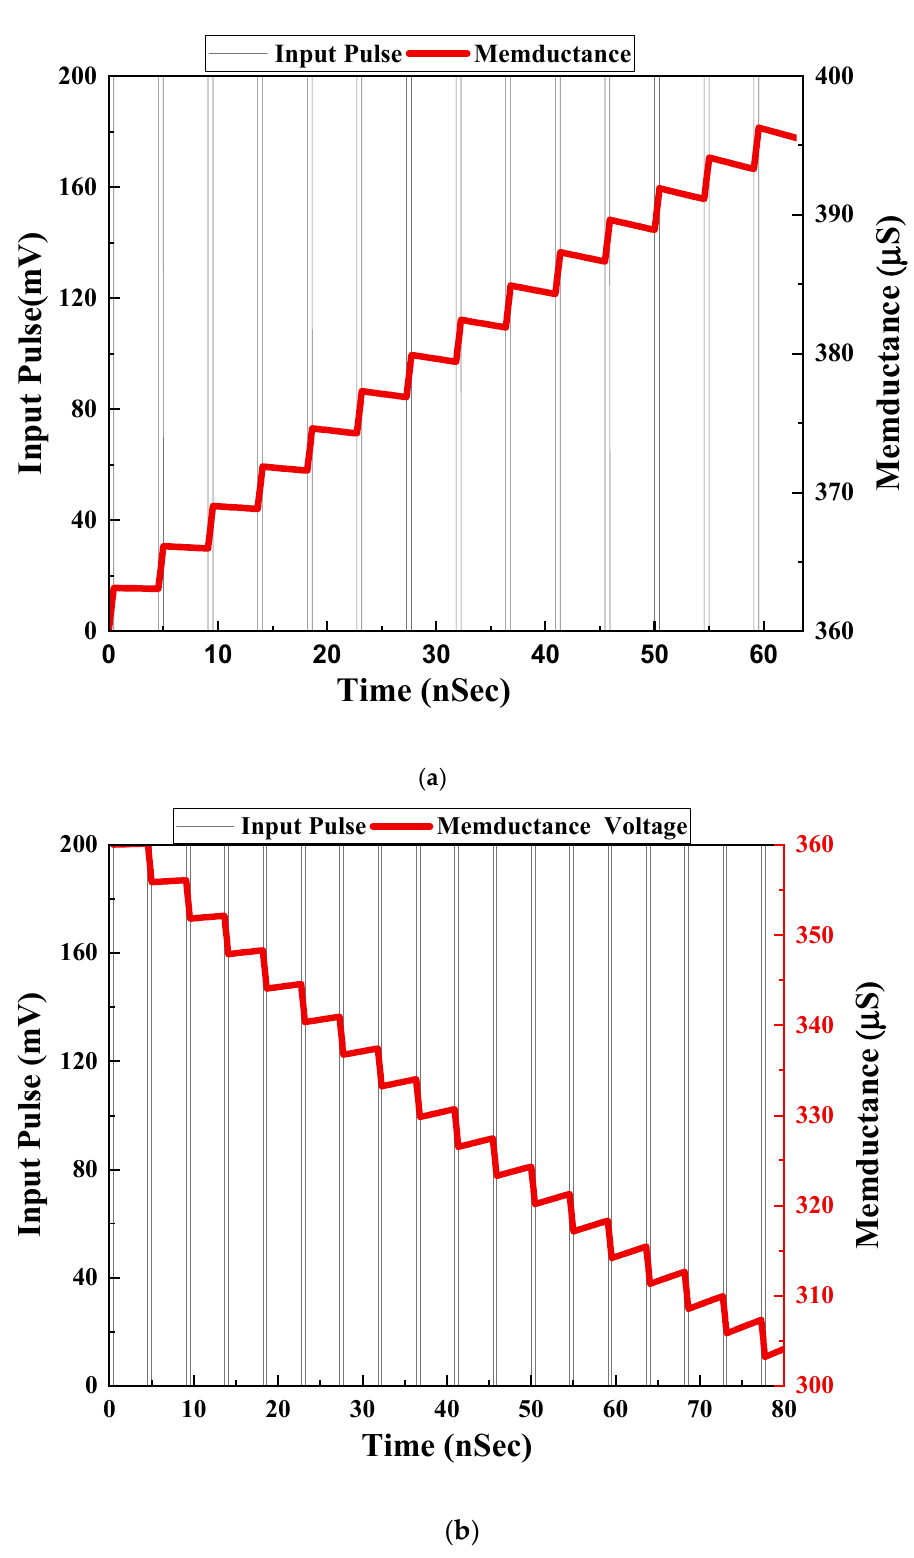
Figure 16. Memductance variation with input pulse for ( a ) incremental configuration and ( b ) decremental configuration.